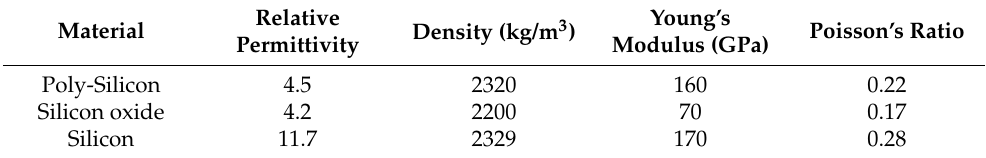
Table 2. Mechanical material properties used for FEM simulations.